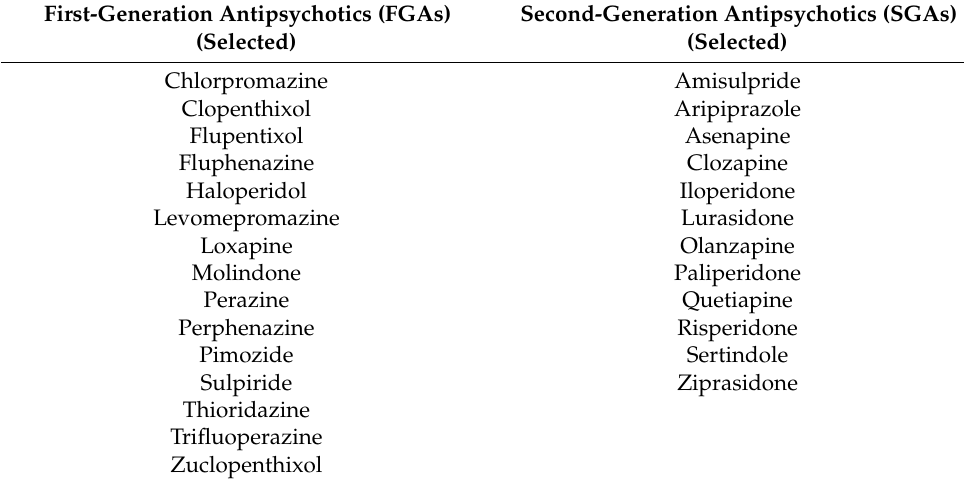
Table 1. Division of antipsychotics by generation based on